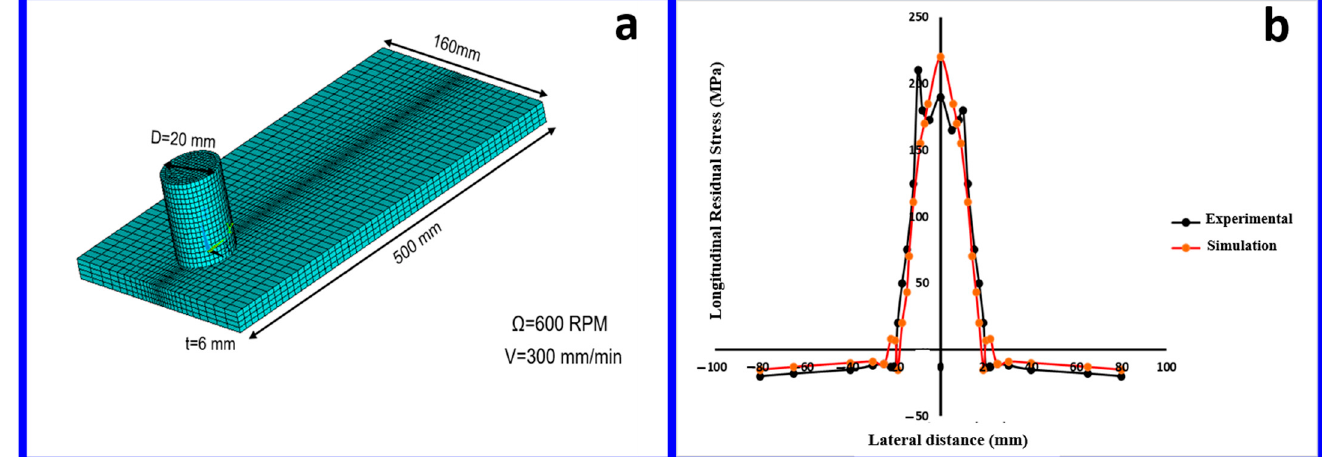
Figure 14. ( a ) FEM modeling and verification of the Lagrangian approach of [15]; ( b ) simulation of the RS of the FSW process and comparison with experimental data.